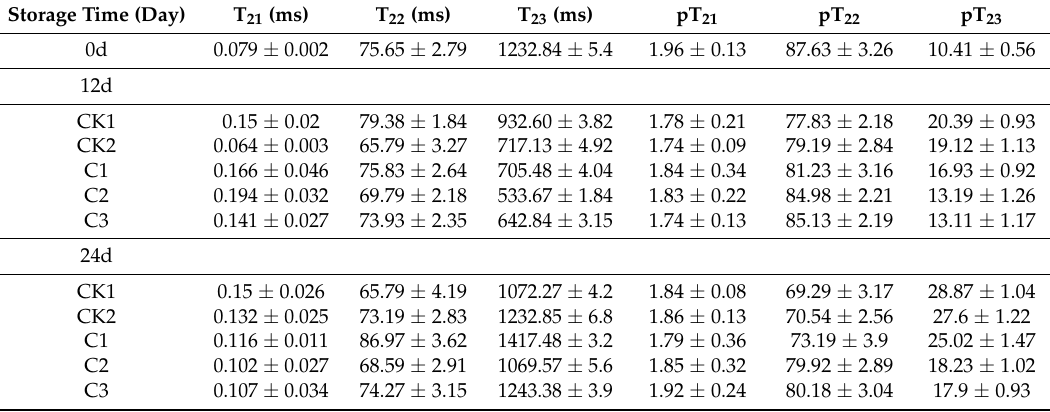
Table 1. Changes of transverse relaxation time and relative content of three water component in HTS fillets with different treatments during the refrigerated